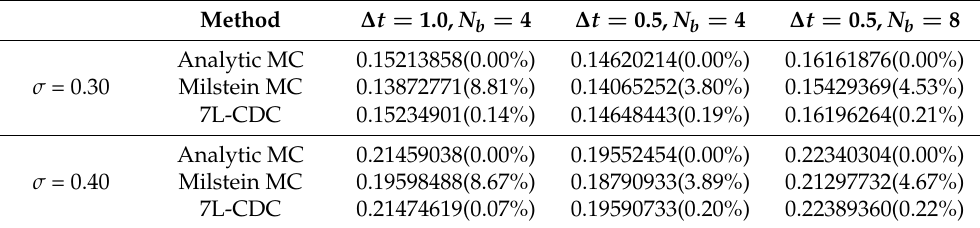
Table 5. Bermudan put option prices based on large time step Monte Carlo